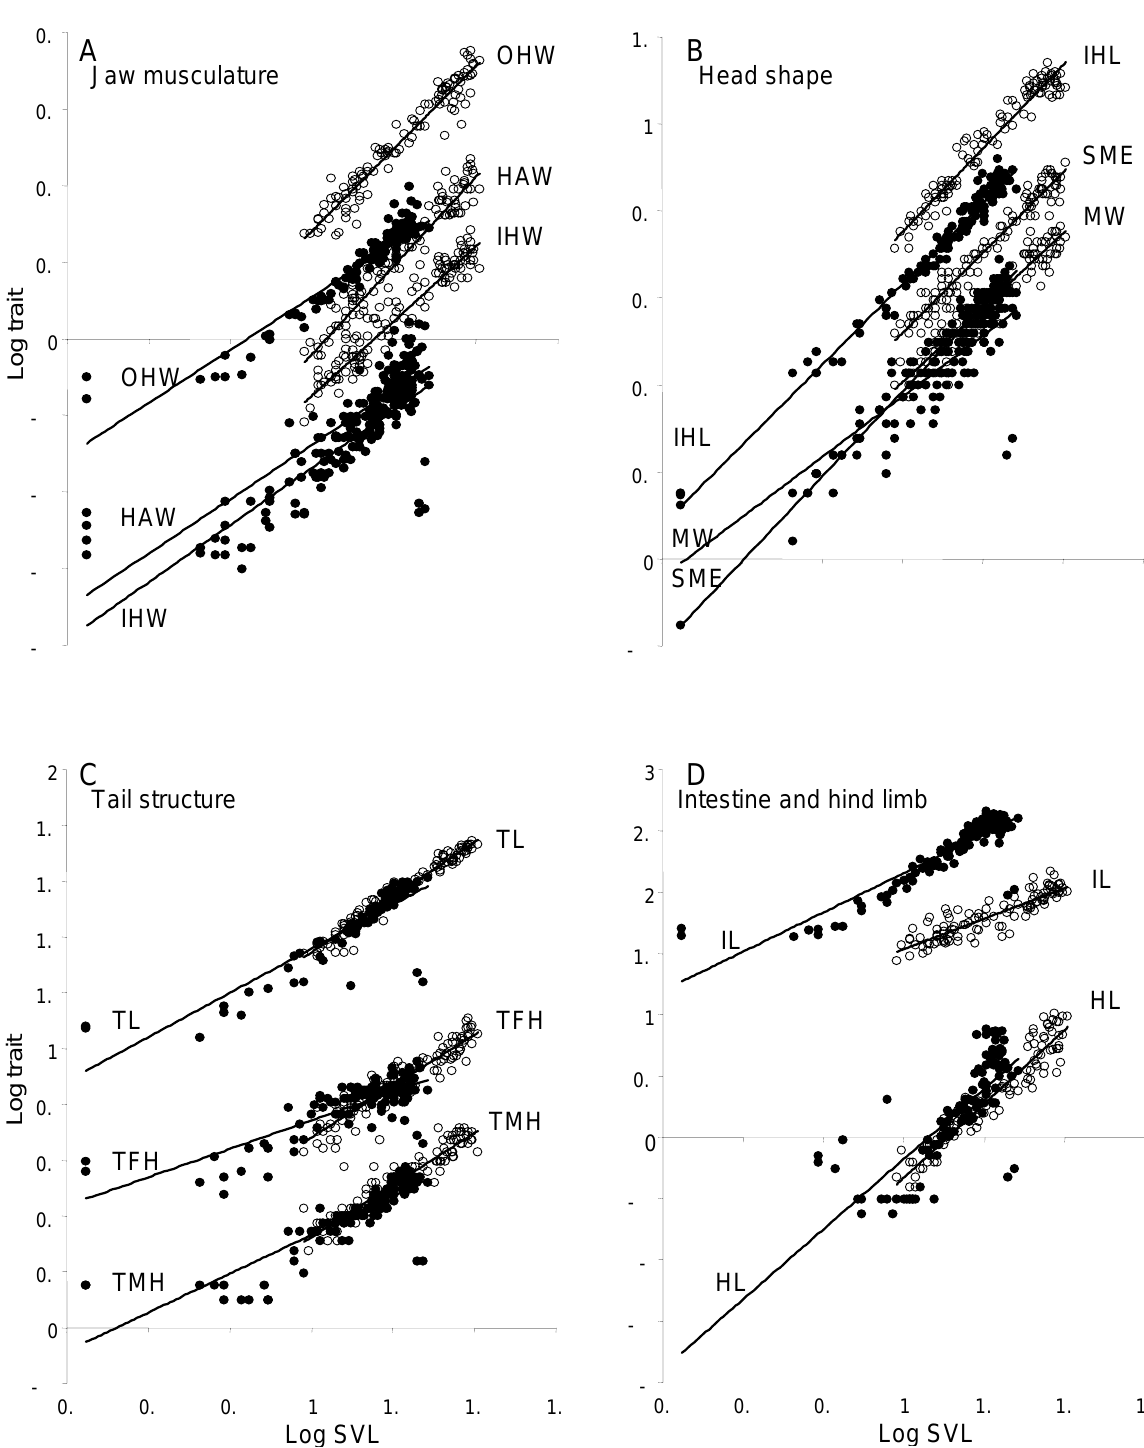
FIGURE 3 . Simple linear regression of log-transformed traits on log SVL for carnivores (open symbols) and omnivores (filled symbols). (A) Jaw-musculature measurements, (B) head measurements, (C) tail measurements, (D) intestine length and hind-limb length. Large differences are apparent in jaw musculature, tail morphology, and intestine development. OHW, orbitohyoideus width; HAW, hyoangularis width; IHW, interhyoideus width; IHL, interhyoideus length; SME, head length; MW, mouth width; TL, tail length; TFH, tail-fin height; TMH, tail-muscle height; IL, intestine length; HL, hind-limb